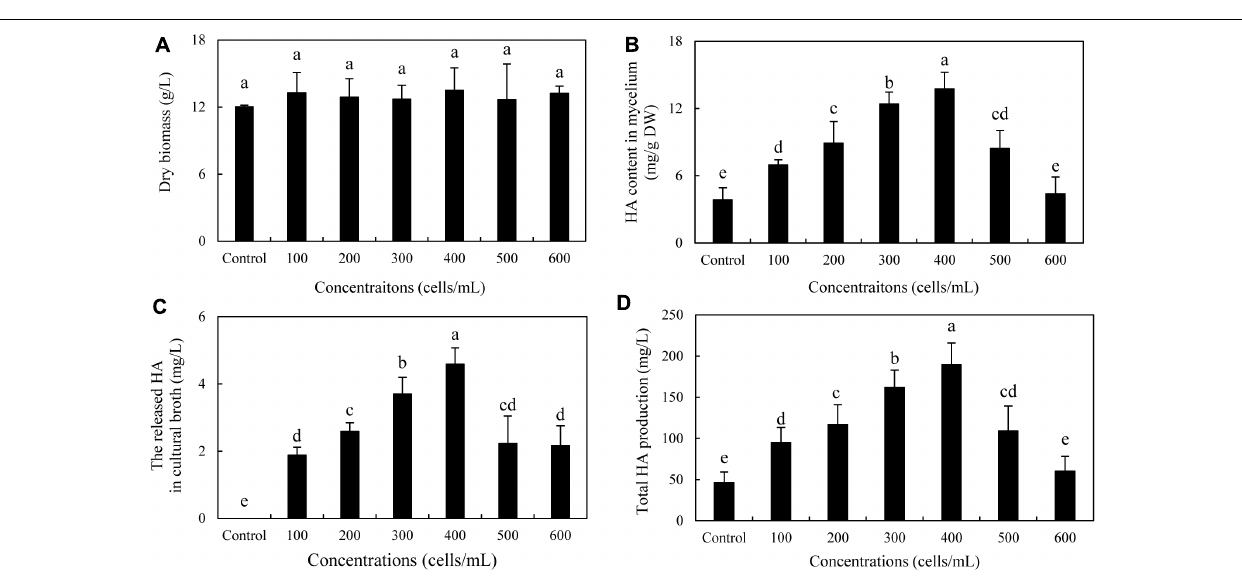
FIGURE 8 | Effect of live SB1 treatment at different concentrations on mycelium dry biomass (A) , HA content in mycelium (B) , the released HA in cultural broth (C) , and total HA production (D) in submerged culture of Shiraia sp. S9. The culture was maintained in a 150-ml flask containing 50 ml of the liquid medium at 150 rpm and 28 ◦ C for 8 days and treated by live SB1 on day 4. The control represents the condition with no live SB1 treatment. Values are mean ± SD from three independent experiments. Different letters above the bars mean significant differences ( p <